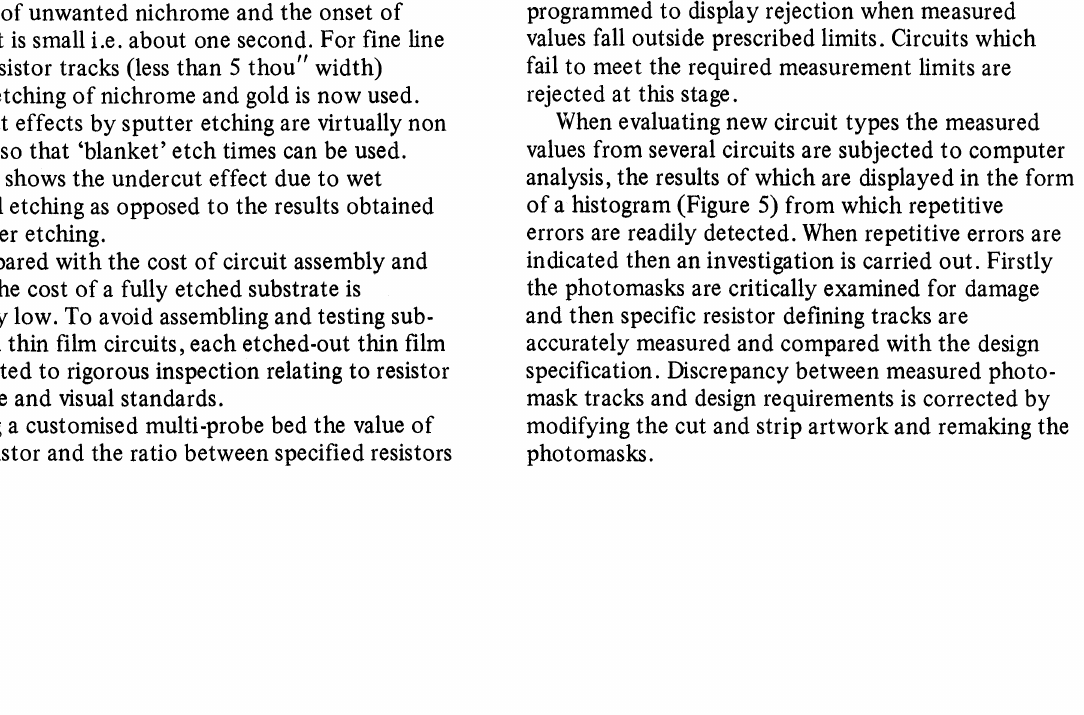
FIGURE 4 Etching of resistors (resistors are shown in black and are 5 thou" wide). (a) Undercutting effect due to wet chemical etching, (b) Zero undercutting with sputtered